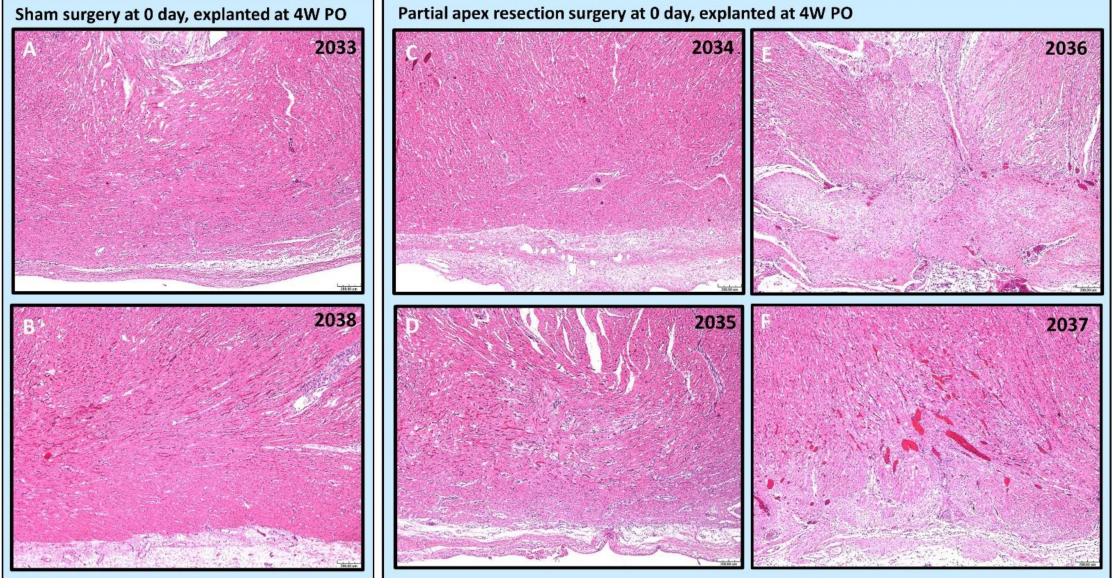
Figure 7. Partial apex resection surgery at 0 days and heart explanted at 4W PO-Hematoxylin and Eosin (H & E) histology of 0-day control hearts and 0-day surgery hearts. Heart explants were obtained four weeks post-operation (4W PO). ( A ) Zero-day control (sham) heart from piglet #2033. ( B ) Zero-day control (sham) heart from piglet #2038. ( C ) Zero-day surgery heart from piglet #2034. ( D ) Zero-day surgery heart from piglet #2035. ( E ) Zero-day surgery heart from piglet #2036. ( F ) Zero-day surgery heart from piglet #2037. Histological images were taken at 4 × magnification (Scale bar = 200 µ m). H & E: pink–cytoplasm; blue–nuclei; intense